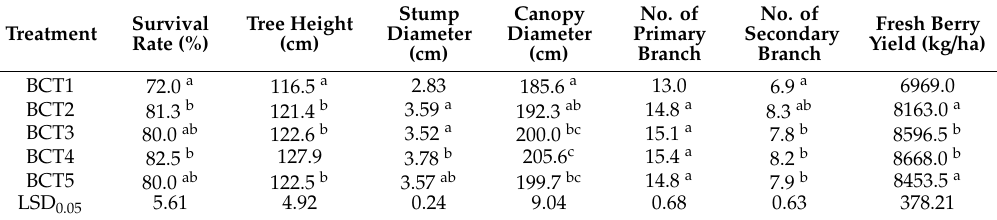
Table 3. Survival rate, growth rate and fresh berry yield by biochemical